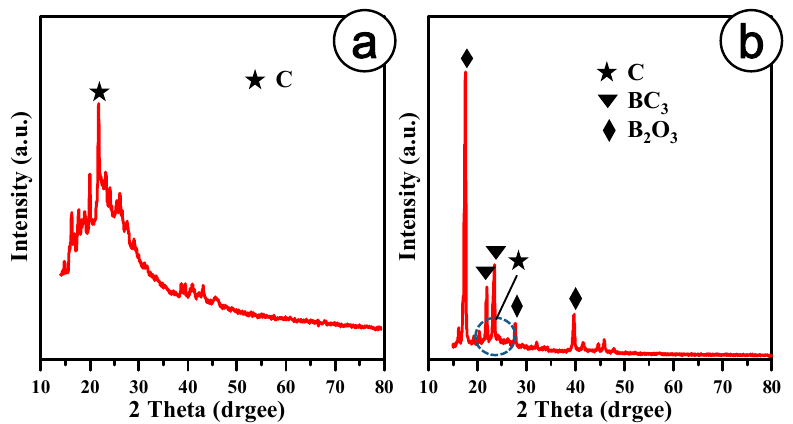
Figure 2. Typical XRD patterns of ( a ) N-doped GQD and ( b ) B-N-codoped GQD samples. The XPS measurements were adopted to analyze the variations in the dopant